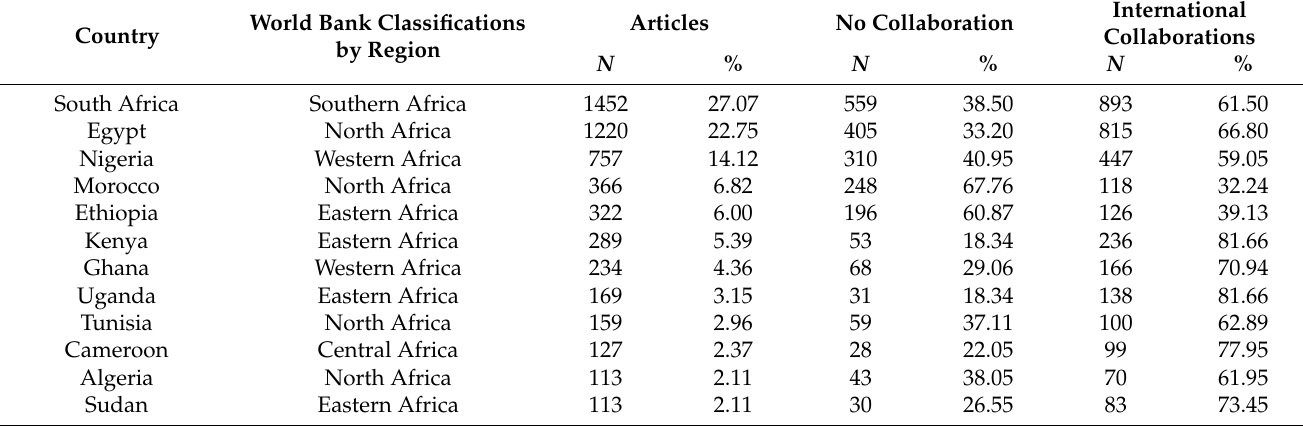
Table 2. Africa scientific production on COVID-19, by country. N represents the number of articles and % the percentage. World Bank Classifications Country by